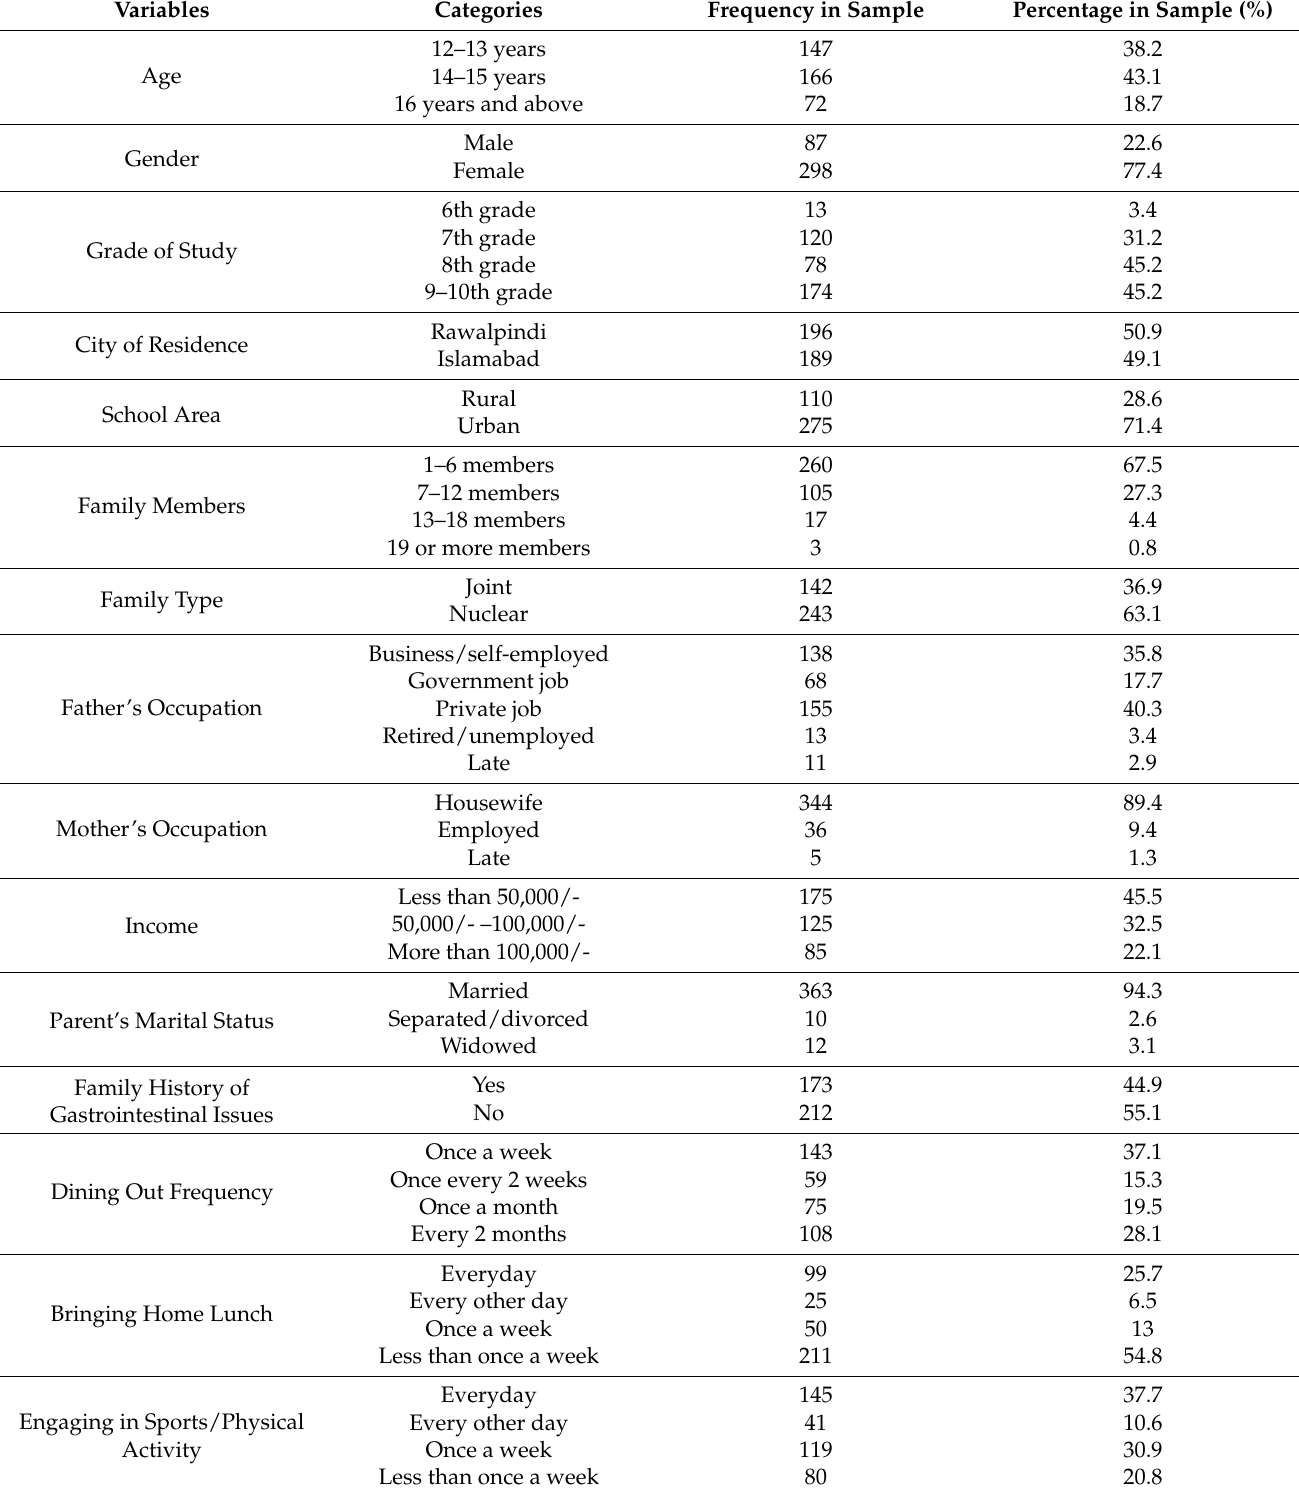
Table 1. Socio-Demographic and Lifestyle Data for School Children Enrolled in the Study ( n =